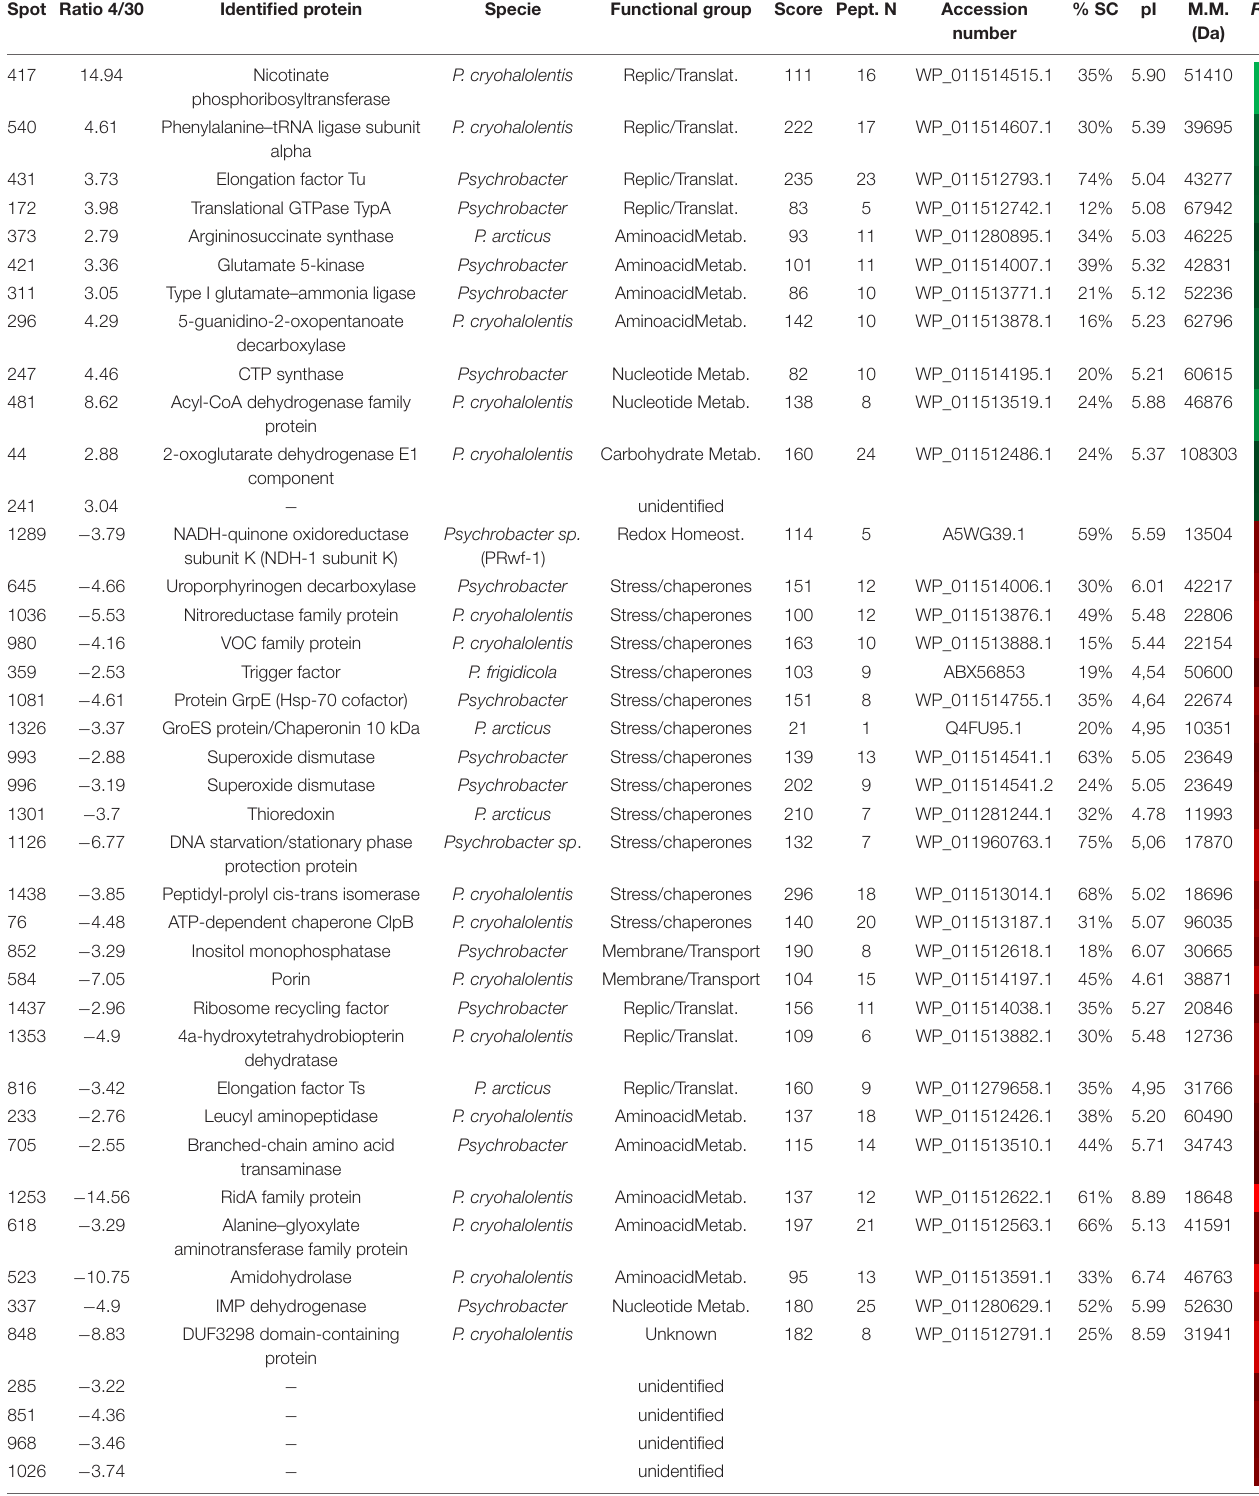
R* represents a heatmap of the ratio 4/30 so the level of overexpression in each case being more brilliant at higher values and darker at lower. A specie column refers to the organisms (specie or genus) in which protein has been identified according to the NCBI